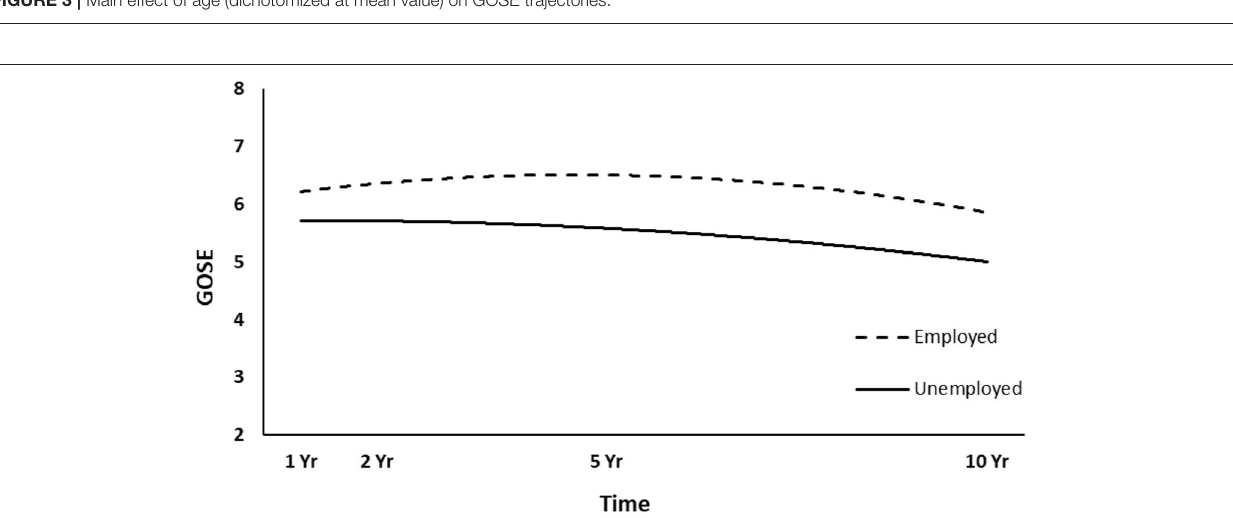
FIGURE 4 | Main effect of employment at time of injury on GOSE